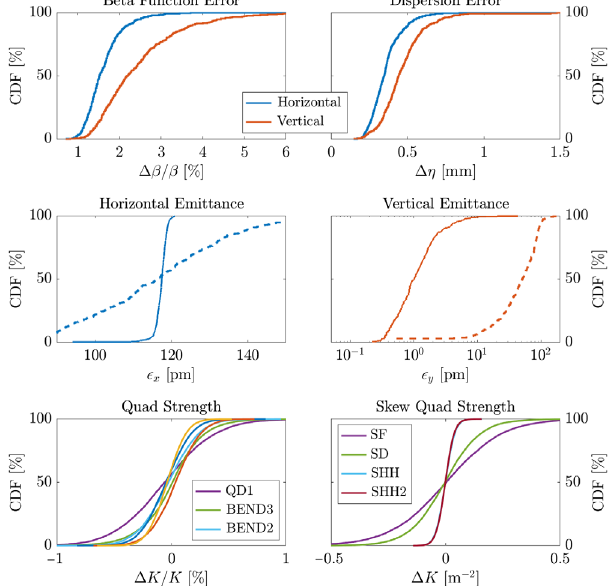
FIG. 14. Visualization of LOCO results. Cumulative distribu- tion functions (CDF) of beta beat, dispersion error, and emittance each before (dashed) and after (solid) optics correction in the upper four plots.. The lower two plots show the final relative quadrupole set-point deviation from the design value (left) and the required skew quadrupole strength (right).